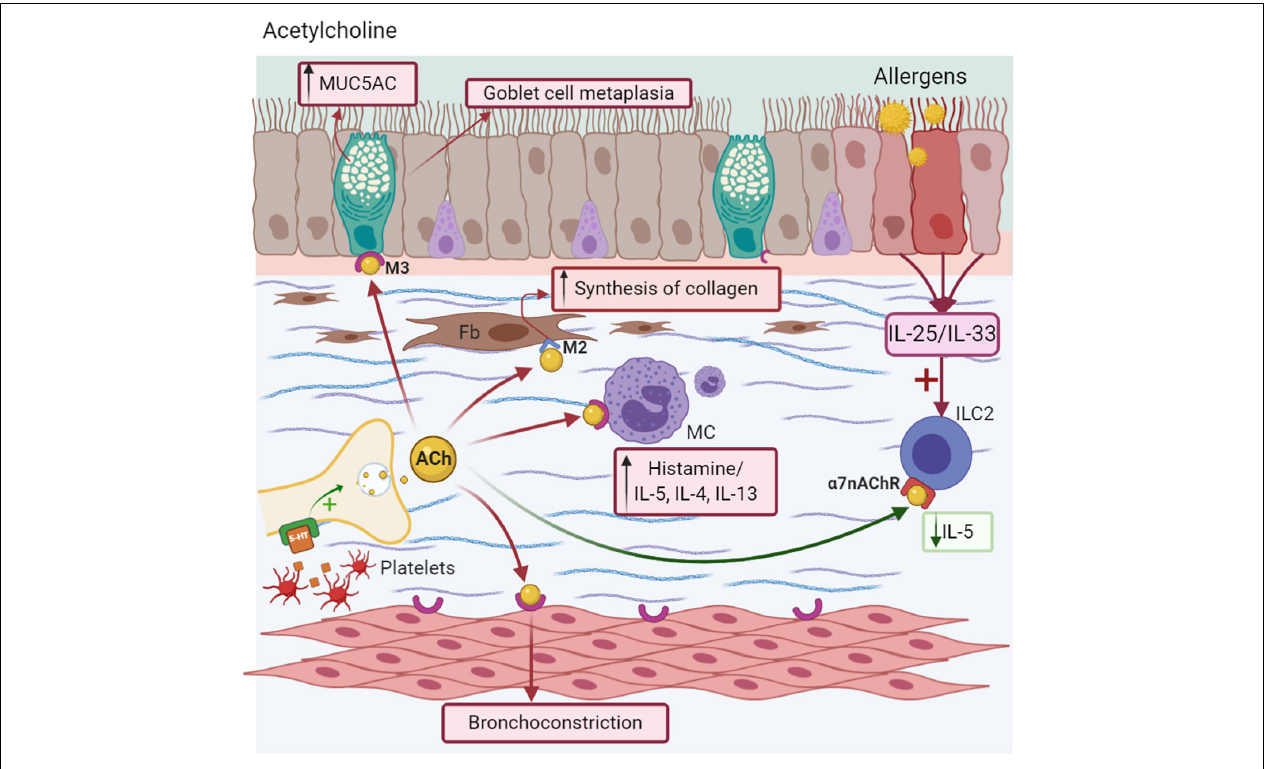
FIGURE 3 | Acetylcholine-ACh. Nerve endings release ACh after depolarization or 5-HT stimuli, causing goblet cell metaplasia, MUC5AC secretion, and bronchoconstriction. It induces Mast cells (MC) degranulation via the M3 receptor and collagen deposition in fibroblast (Fb) via the M2 receptor. Anti-inflammatory effects as decreasing of IL-5 synthesis are due to the α 7nAChR activation in